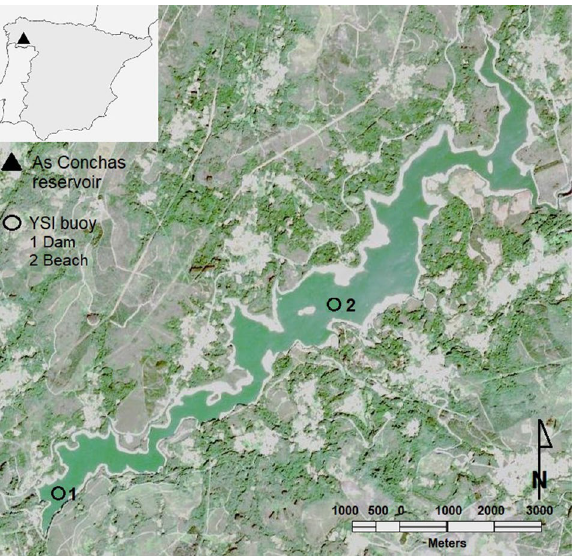
◦ ◦ 56’41.78”N; 8 1’47.96”W) and (2) beach